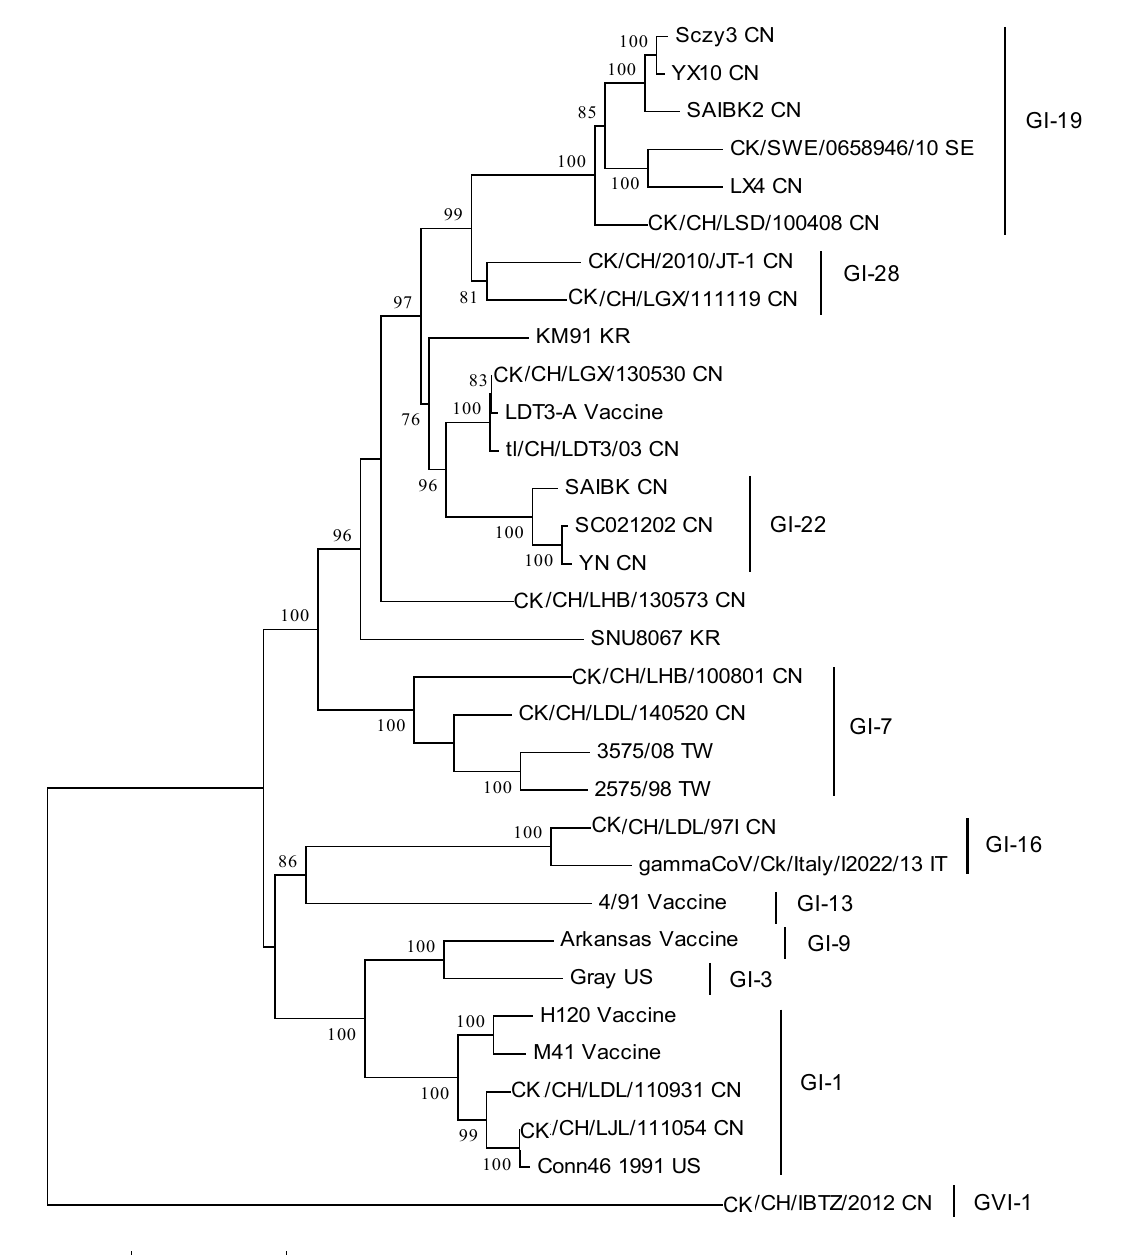
Figure 1. Phylogenetic analysis of the complete S1 gene of the IBV variants reviewed in this study and reference strains. The phylogenetic tree was constructed using MEGA version 6 by the neighbor-joining method (bootstrapping for 1000 replicates, bootstrap value >70%). CN: China; IT: Italy; KR: Korea; SE: Sweden; TW: Taiwan; US: United States.